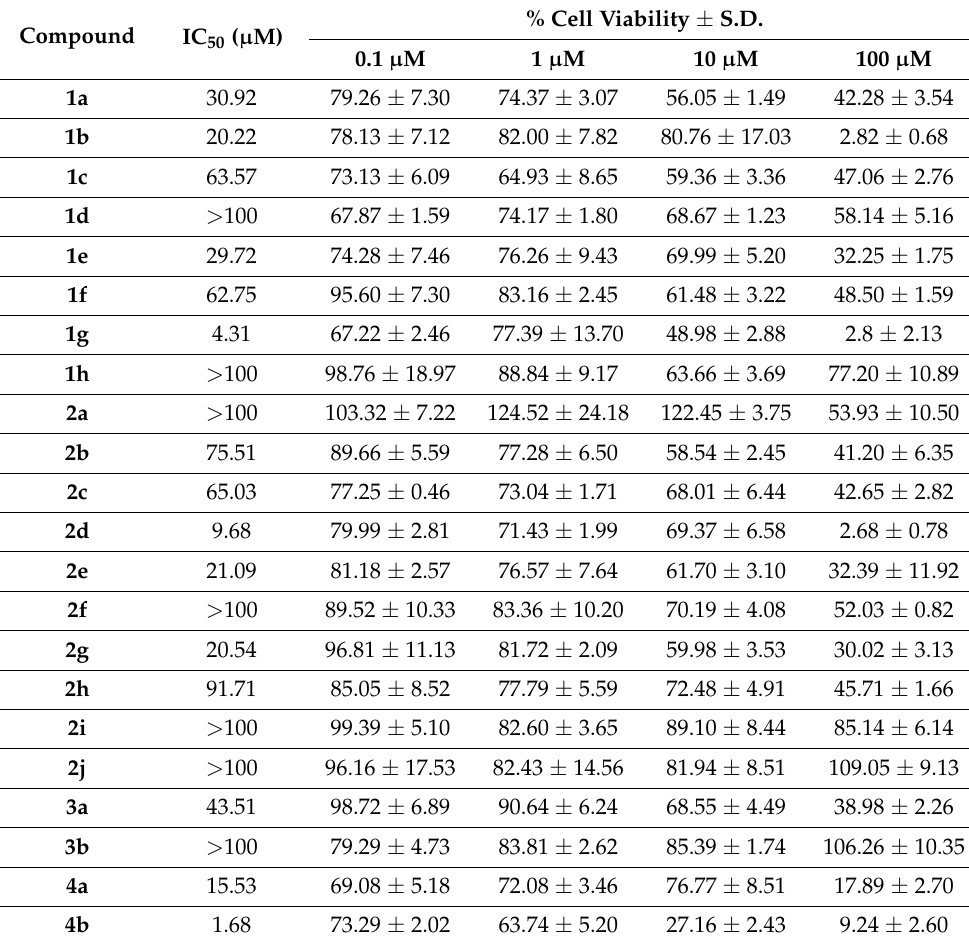
Table 1. Cell viability analysis of newly synthesized compounds in human neuroblastoma cell lines. All values are means ± SDs ( n =